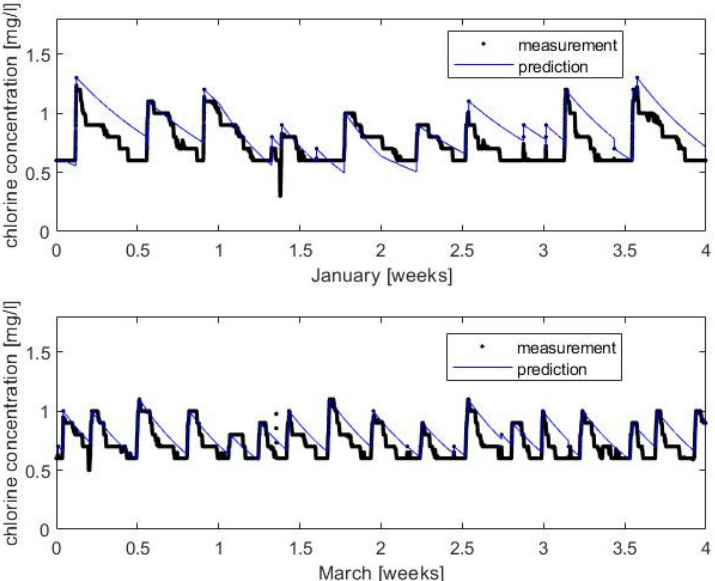
Figure 5. Chlorine decay model validation at the output of T 2 . Up: data from January 2017. Down: data from March 2017. Due to high frequency of sampling measurement, data appears like a thick line.